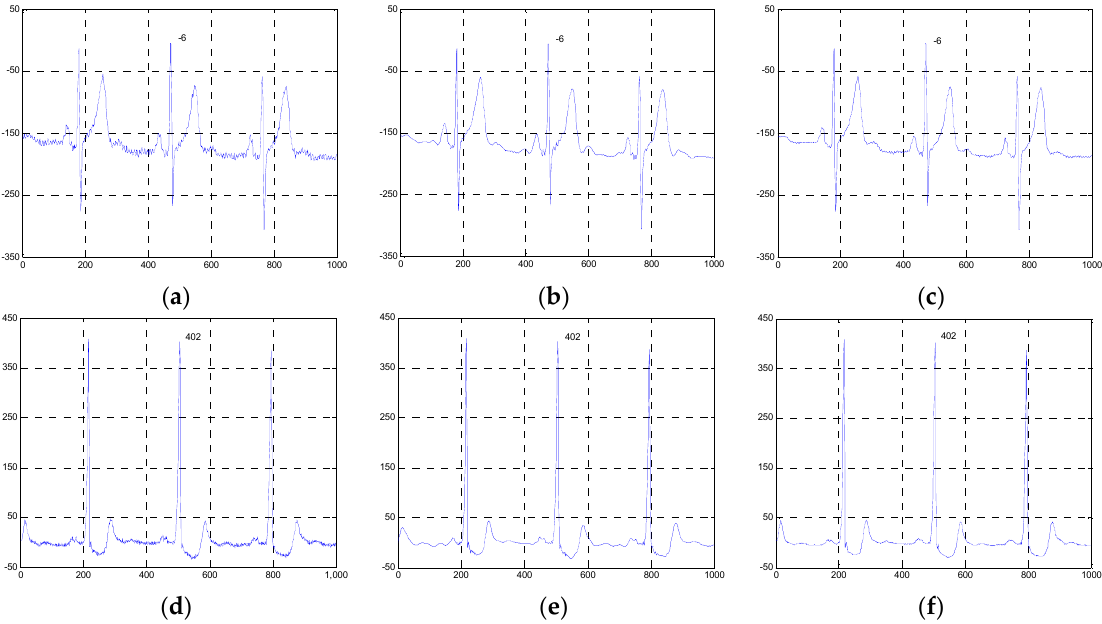
Figure 14. Comparison of the denoised results for the ESMD-NLM and NLM methods operating on the sel117m.dat and sel114m.dat in the second group of clinical ECG signals. ( a ) The clinical ECG signal (sel117m.dat), ( b ) the ESMD-NLM method (sel117m.dat), ( c ) the NLM method (sel117m.dat), ( d ) the clinical ECG signal (sel114m.dat), ( e ) the ESMD-NLM method (sel114m.dat), ( f ) the NLM method (sel114m.dat).